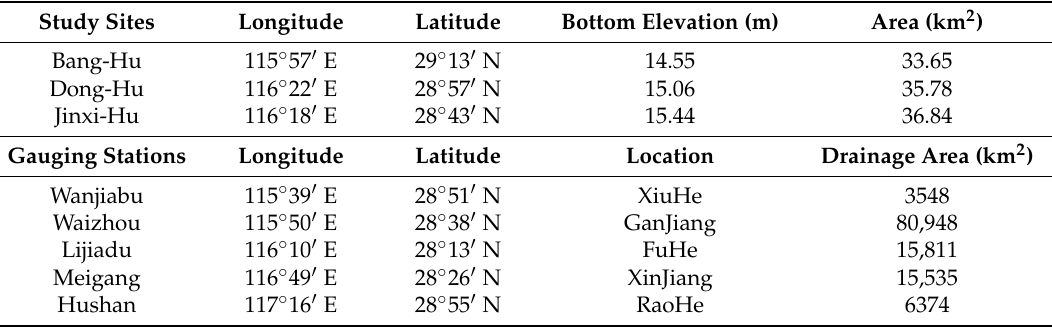
Table 1. List of the geographical and physical features of the study sites and gauging stations. Study